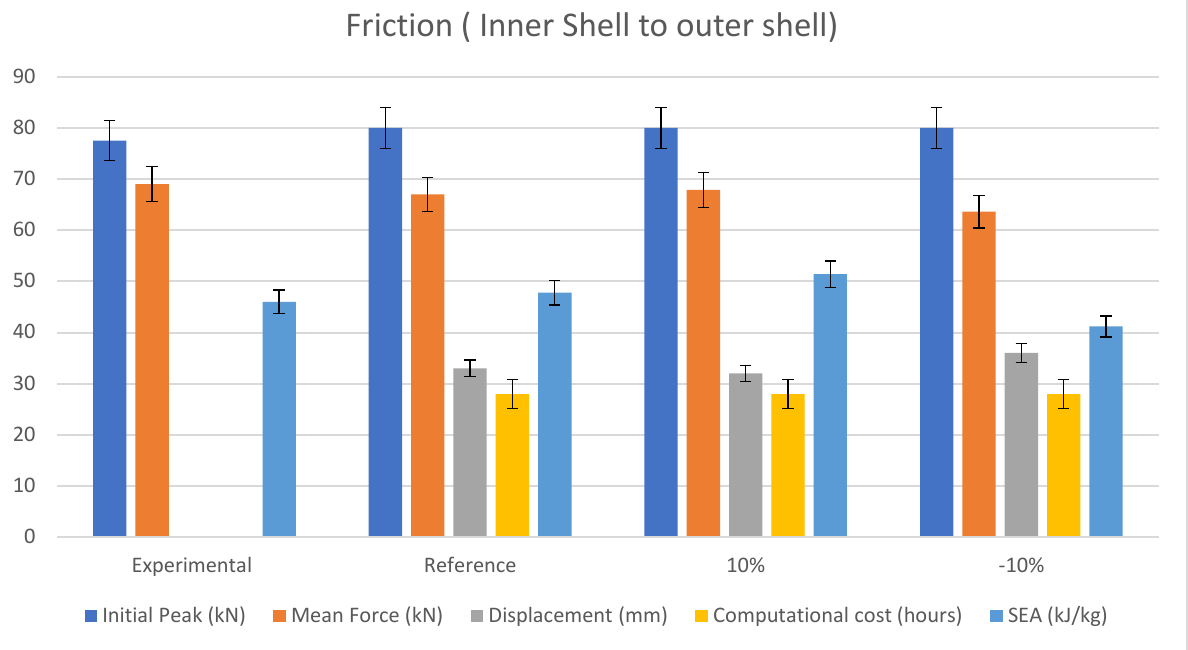
Figure 21. Inner-shell to outer-shell friction coefficient comparison [66].